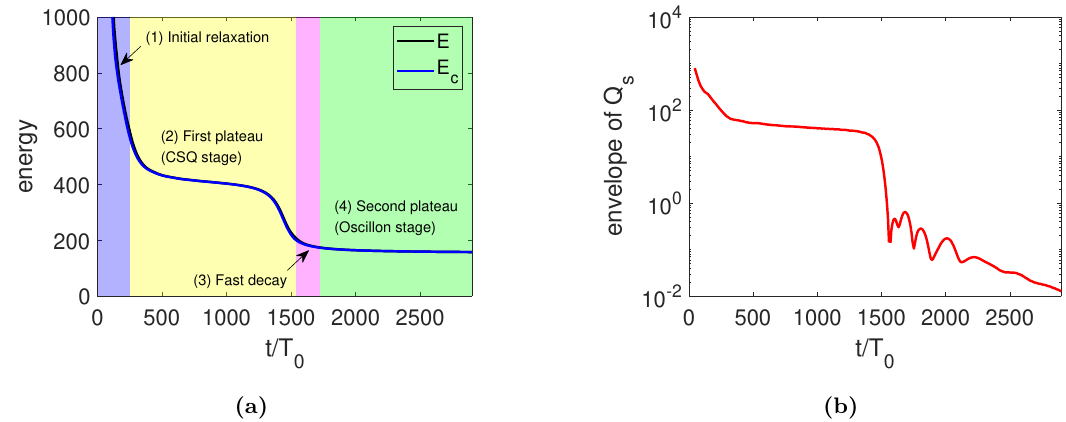
Figure 30. Evolution of energy E and E c and envelope of charge Q s for a dipole CSQ in 3+1D. The initial constituents are elementary Q-balls with frequency ω = ± 0 . 84 and spacing d = 10 .